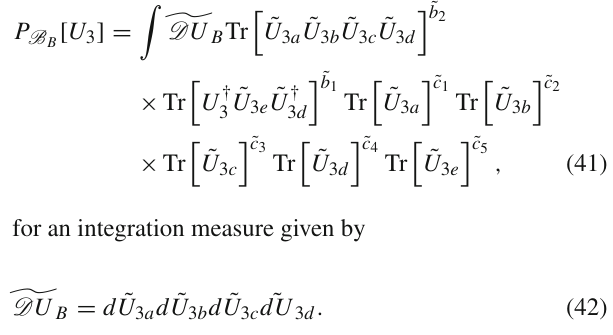
of the polynomial P B B ( l ) . G The blue path associated with the link U 3 is shown in Fig. 4. The blue path associated with the link U 3 includes the plaquette occupation numbers associated with the first neighbor plaquette Tr [ U † second neighbor Tr [